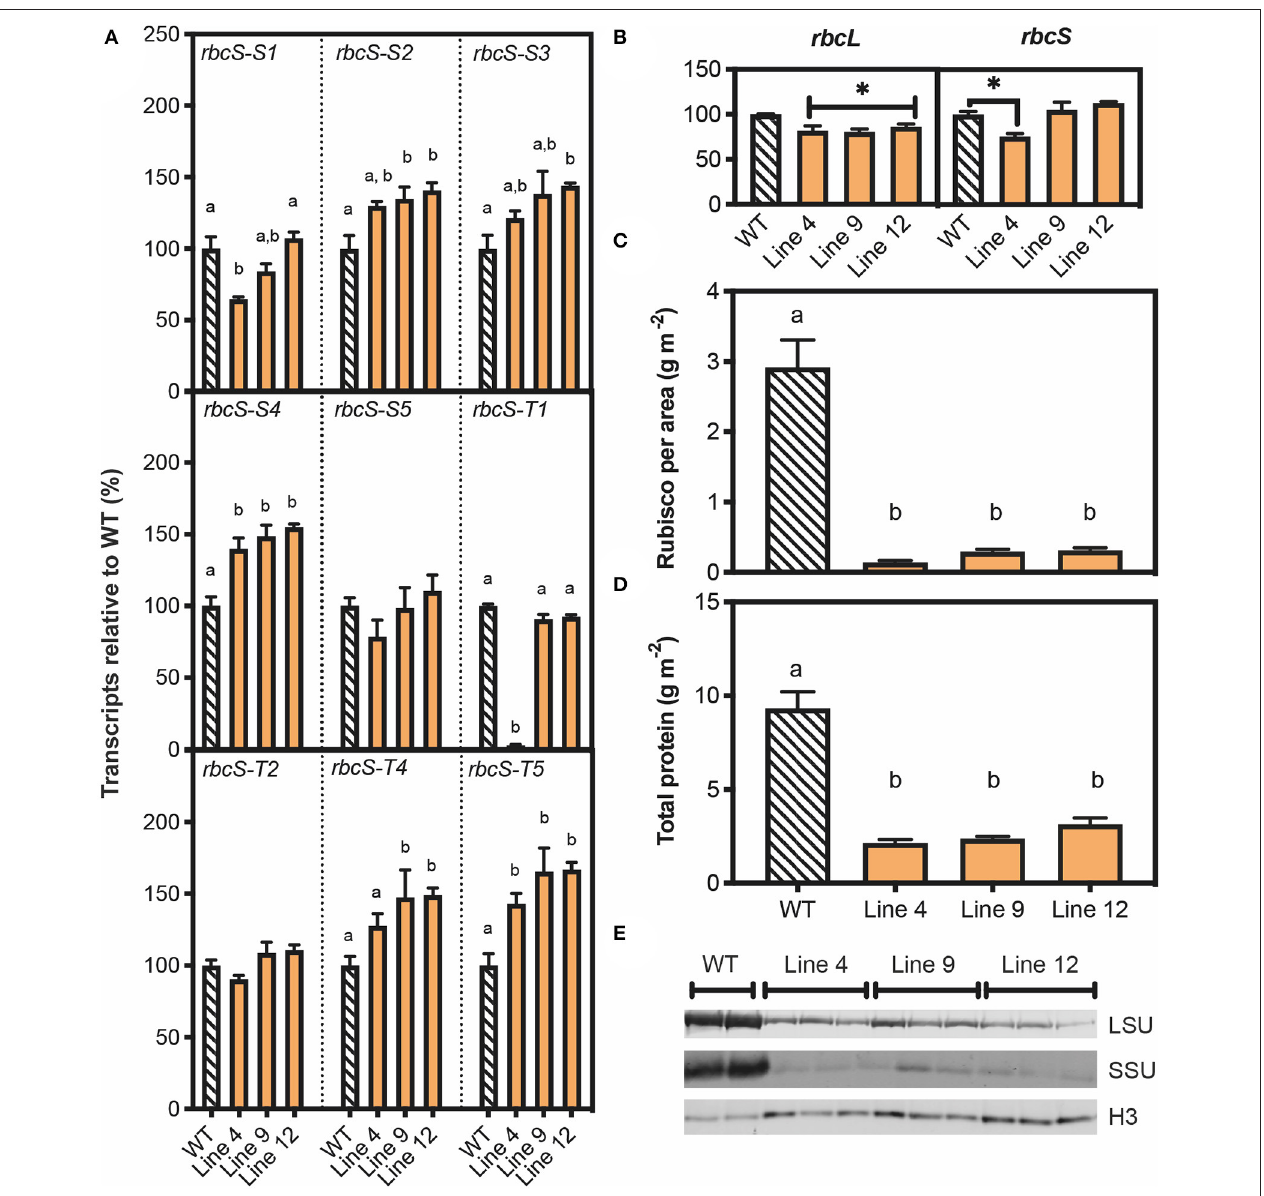
FIGURE 3 | Molecular analyses of T 1 plants with SpCas9- induced mutations in rbcS-T1. (A) RNA was extracted from 45-day-old plants and the abundance of transcripts for nine rbcS homologs was measured by quantitative PCR (qPCR) with gene-specific primers and the transcript level is shown relative to wild-type (Supplementary Information 1 in Supplementary Material ). (B) Abundance of Rubisco large subunit transcripts ( rbcL) and total rbcS transcripts. The latter was calculated by combining the results for the nine individual rbcS homologs. (C) Rubisco content per leaf area and (D) total protein per leaf area measured by Bradford assay. (E) Immunoblot of total soluble protein to detect Rubisco large subunit (LSU) and small subunit (SSU) contents, with a histone H3 (H3) loading control. Protein extracted from an equivalent amount of leaf area was loaded. Each lane represents a biological replicate (two for WT and three for each mutant line). All data are the mean ± SEM of three biological replicates. Significant differences between groups ( P < 0.05) as identified by one-way ANOVA and Tukey’s HSD test are shown by different letters. including deletions in rbcS-S1a (1–5 bp) and rbcS-S1b (3-12 bp) ( Supplementary Figure 7D ). Together, these results